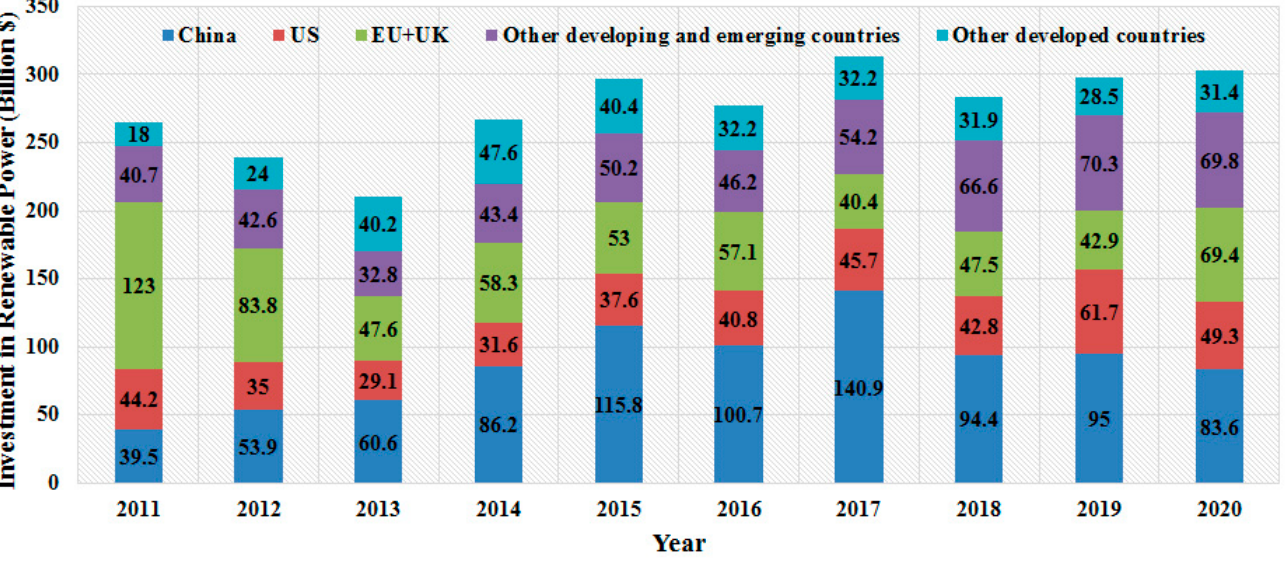
Figure 5. Flow of investment in renewable energy in the world from 2009 to 2019 (in billion USD). Source: REN21 (Renewable Energy Policy Network for the 21st Century) [25]. This was the same percentage as in 2018, however it was down from 62% in 2017.